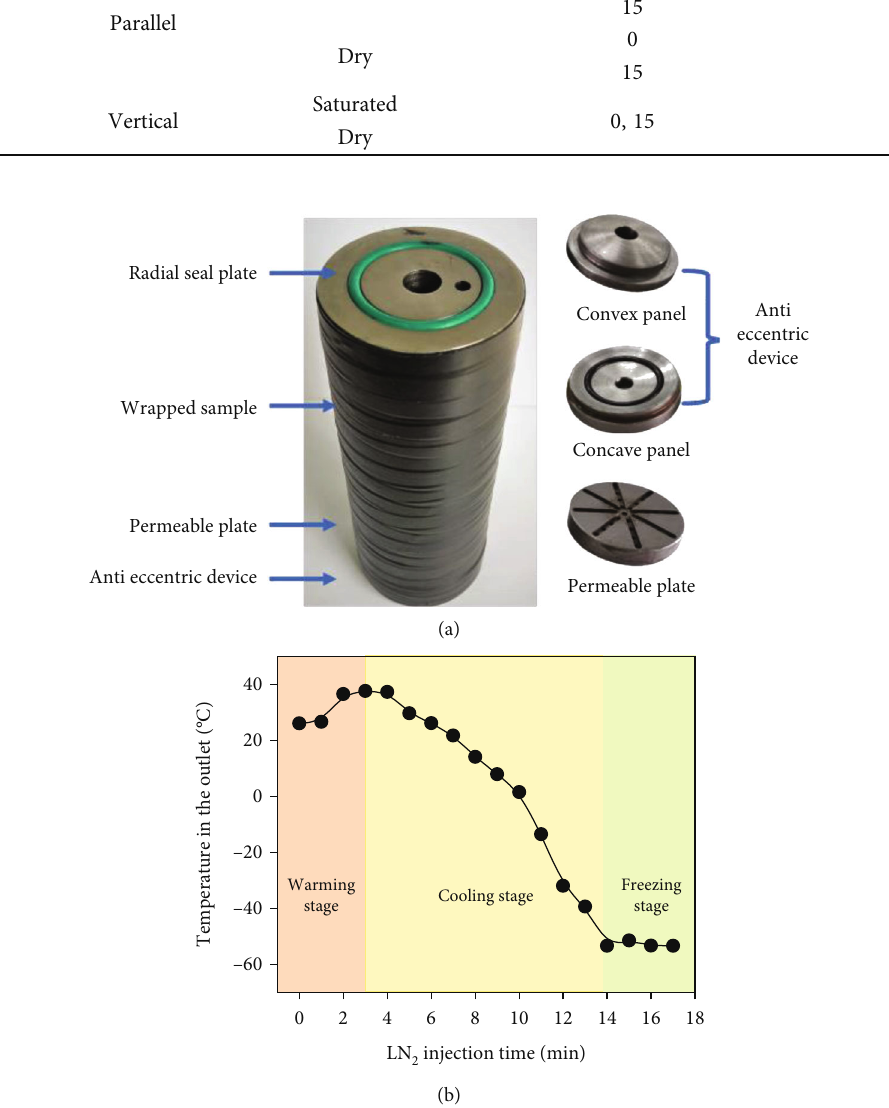
Figure 5: (a) The assembly of sample in the triaxial device. (b) The change of LN